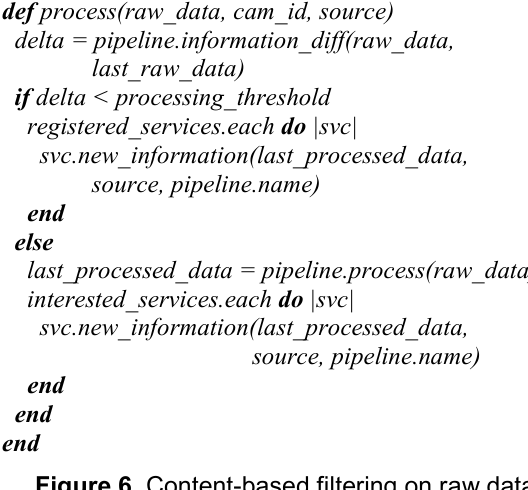
Figure 6. Content-based filtering on raw